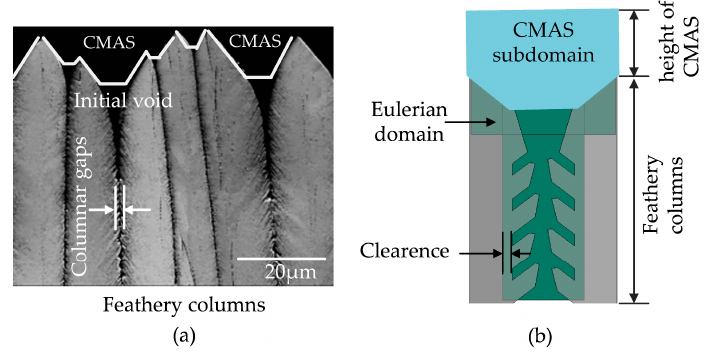
Figure 6. Identification of the CMAS initial position for modeling: ( a ) trapezoidal shape of the CMAS domain is isolated at the top of the columns; and ( b ) microstructure unit cell (MUC) with CMAS sub-domain and Eulerian domains for material flow. Reprinted with permission from [25]; Copyright 2006 Elsevier.